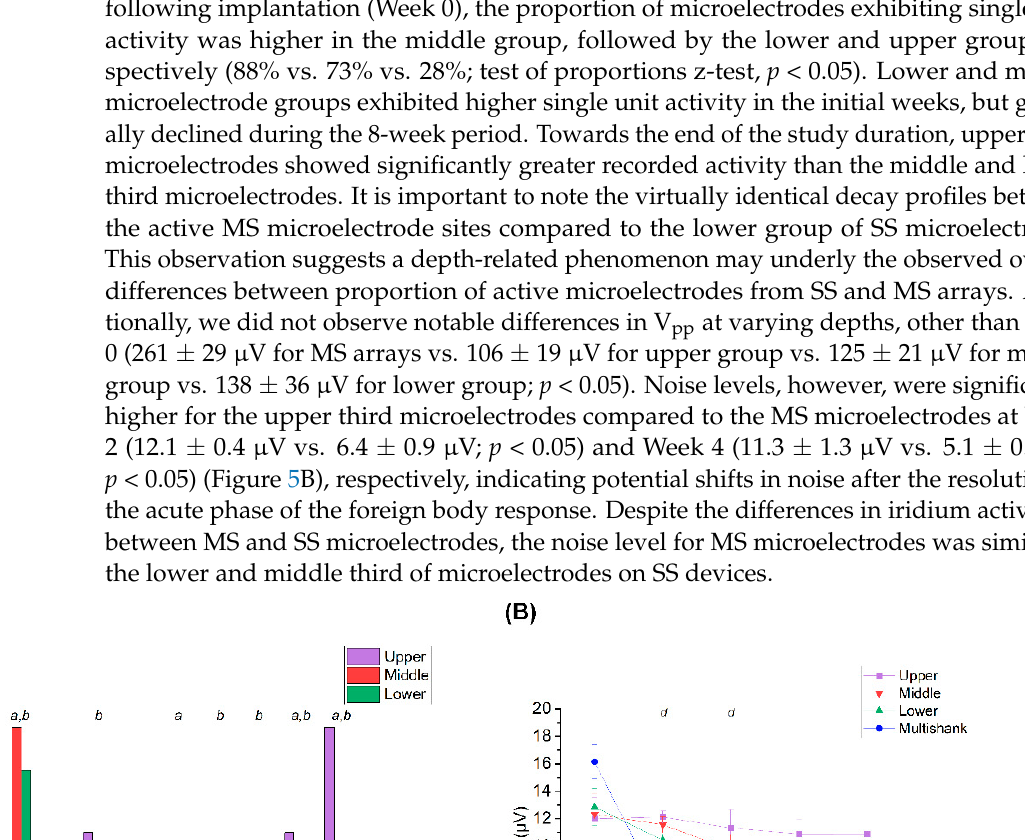
Figure 6. Immunohistological profile of cortical tissue implanted with multi-shank arrays at two depths. The columns indicate activated astrocytes/macrophages (GFAP), neuronal nuclei (NeuN), cell bodies (DAPI) and Composite images. Rows represent tissue collected at superficial (top panel, ~400 μ m) and deeper (bottom panel, ~1000 μ m) depths. The white asterisks (*) on the individual images in the panel indicate the presumptive sites of the device shanks. Scale bar = 100 μ m. Likewise, the neuronal distribution was slightly more pronounced at superficial depths as well. While these findings are preliminary, our observations are consistent with